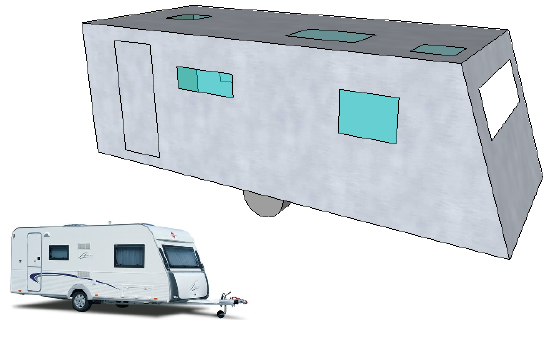
Figure 6. Bürstner TRECENTO 560K and virtual model employed for the simulation.